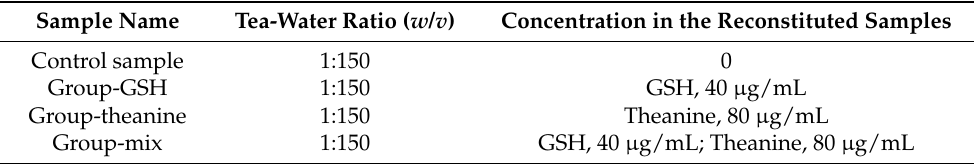
Table 4. The information of reconstituted samples for sensory evaluation.